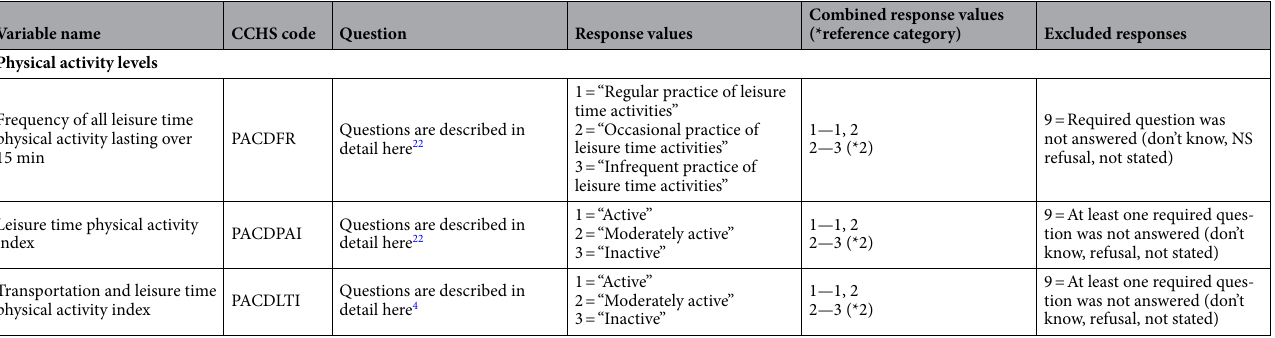
Table 6. Measures of physical activity levels. CCHS Canadian Community Health